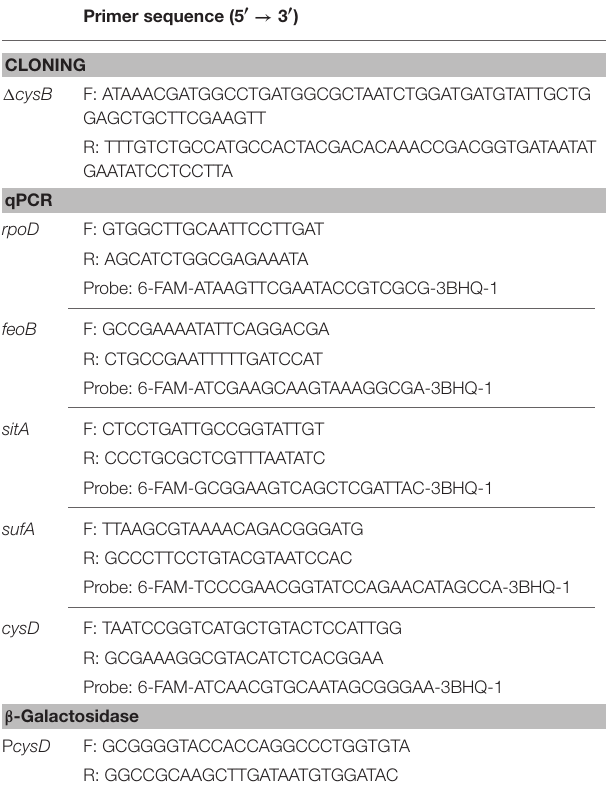
TABLE 2 | Primers used in this